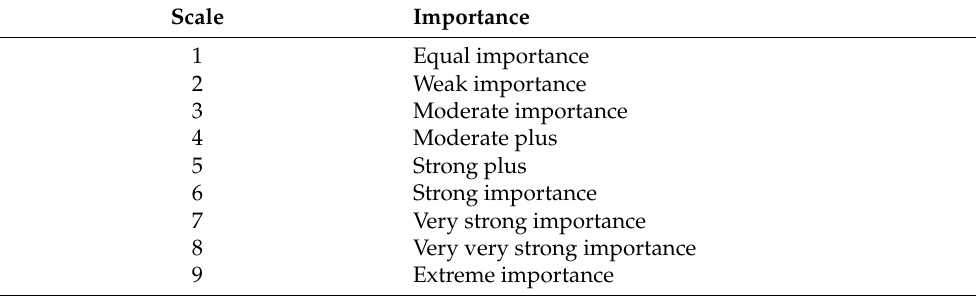
Table 1. Saaty’s 1–9 scale of relative importance